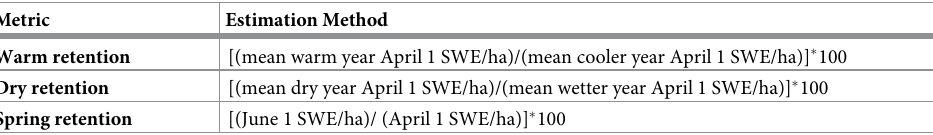
Table 1. Snowpack retention